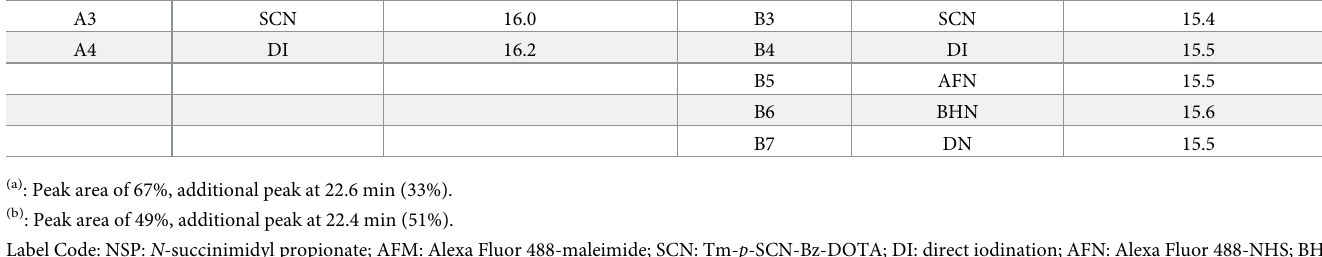
Antibodies that have been treated with maleimide-based labels show an obvious degrada- tion and confirm the finding from mass spectrometry of a fragmented antibody. The corre- sponding SEC shows a peak at the expected migration time of the unlabelled antibody at 16.1 min (mAbA2) and 15.5 min (mAbB2). An additional protein fragment with absorbance at 494 nm at around 22.4 min appeared. Although the molecular weight decreases due the cleavage of light chains, the retention times at around 16 min remains almost the same. The relatively unaltered retention time of the antibody fragments to the unlabelled proteins can be explained by an increase of the hydrodynamic sizes of human IgGs, which was observed after partial reduction of inter-chain disulfide bonds [21]. In an additional SEC experiment, maleimide labelled mAbB2 was treated by the addition of 0.1% formic acid (protein solution to formic acid 1:1 v/v) prior to injection. The main peak (mAbB2) at 15.5 min has disappeared and sev- eral peaks eluted at 16.0 min, 16.8 min, 20.4 min, 24.1 min, and 24.9 min (Fig 5). So, possibly, under non-denaturing conditions of the SEC, the reduced antibody was stabilized through a non-covalent interaction (ionic, hydrogen bonds, Van der Waals, or hydrophobic) and remained as intact protein at 15.5 min. However, after denaturation at low pH, the molecule divided into individual chains. This indicates that the disulfide bridges could not be reestab- lished after the labelling. Free thiol groups may have an unexpected impact on the PK proper- ties of the therapeutic protein and should be avoided if possible.